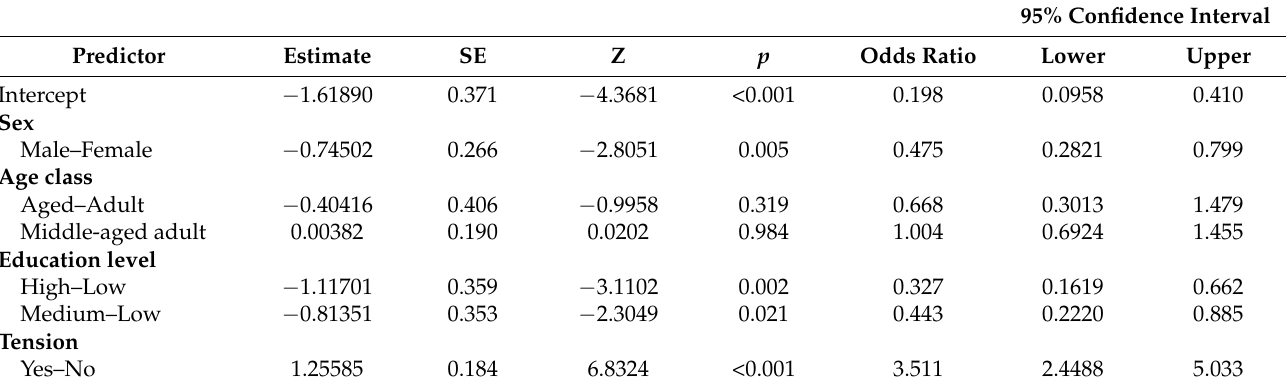
Table A4. Results of Multivariate Regression Analysis Models, with Quality of Sleep as Dependent Variable and Feeling of Tension and Sociodemographic Characteristics as Independent Variables.